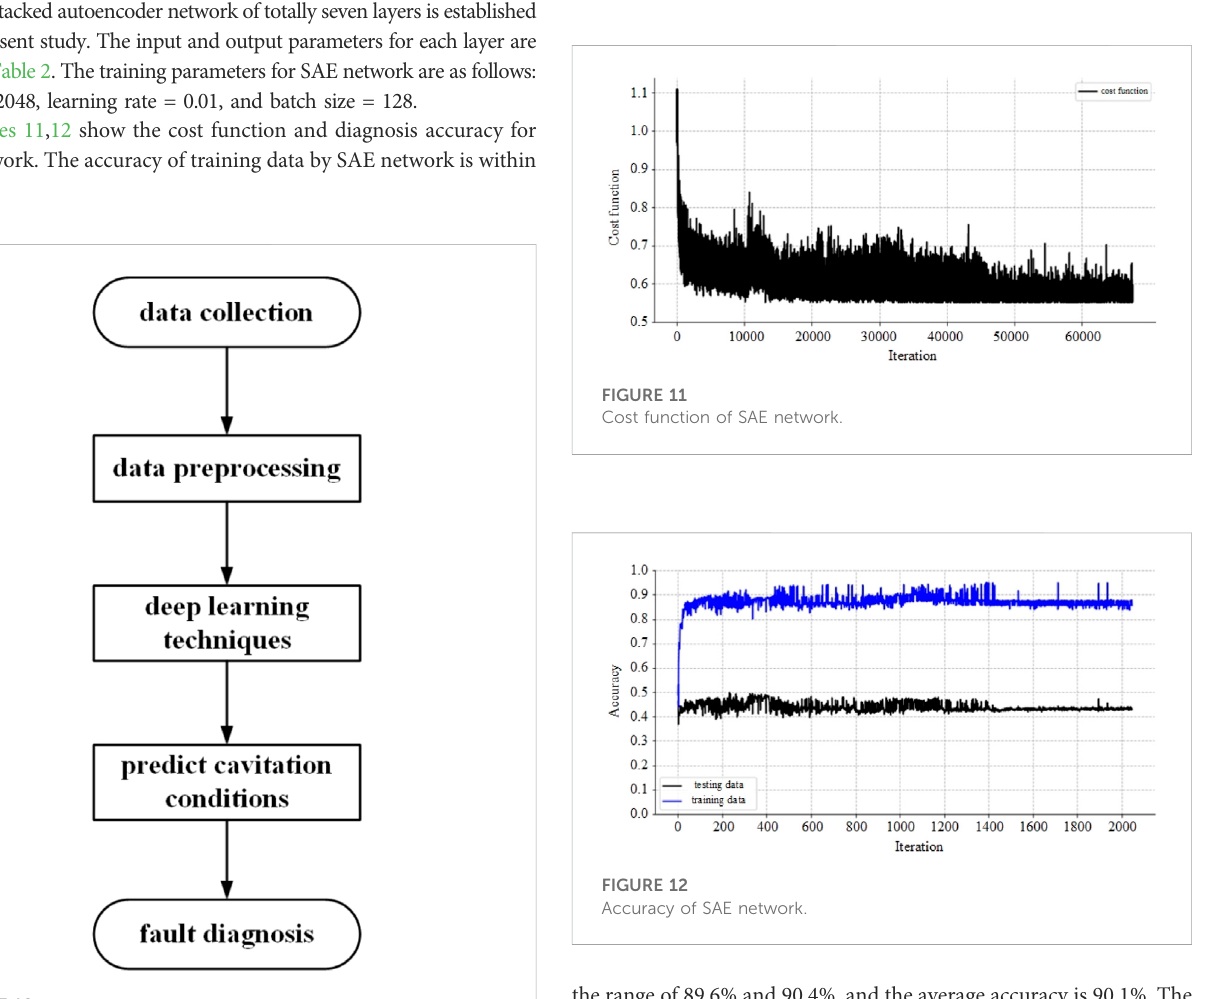
FIGURE 10 Flow chart of fault diagnosis.